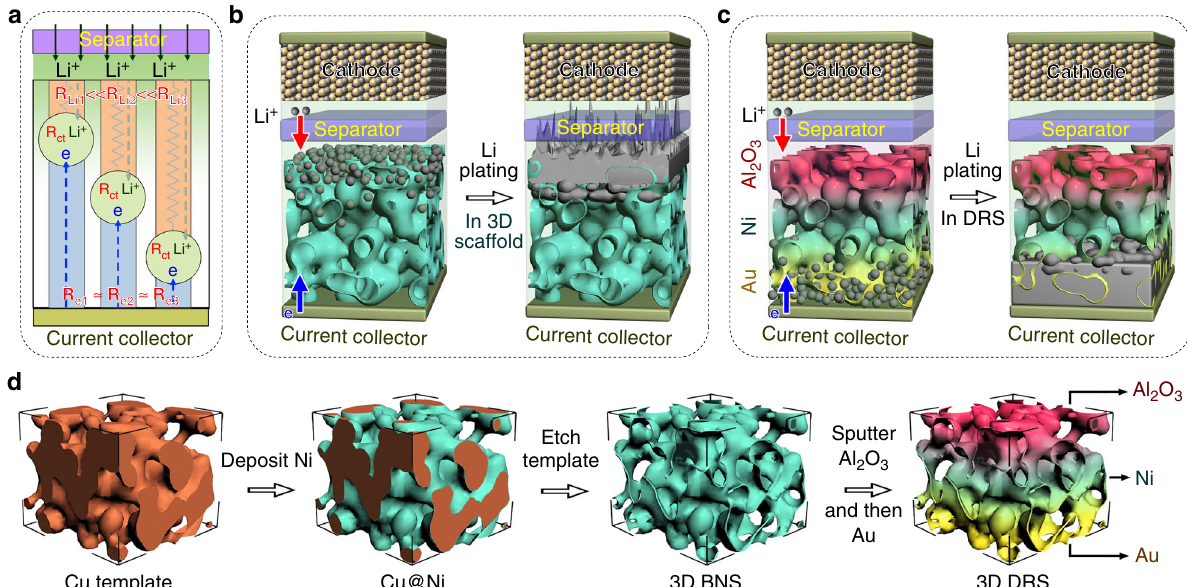
Fig. 1 Top – and bottom – up growth modes, and the DRS fabrication route. a The variation of transport resistances of Li-ion and electron, and charge-transfer resistances in the through-thickness direction of a Li anode. b The top-growth mode at the anode/separator interface. c The bottom – up Li deposition in a DRS anode. d The DRS fabrication